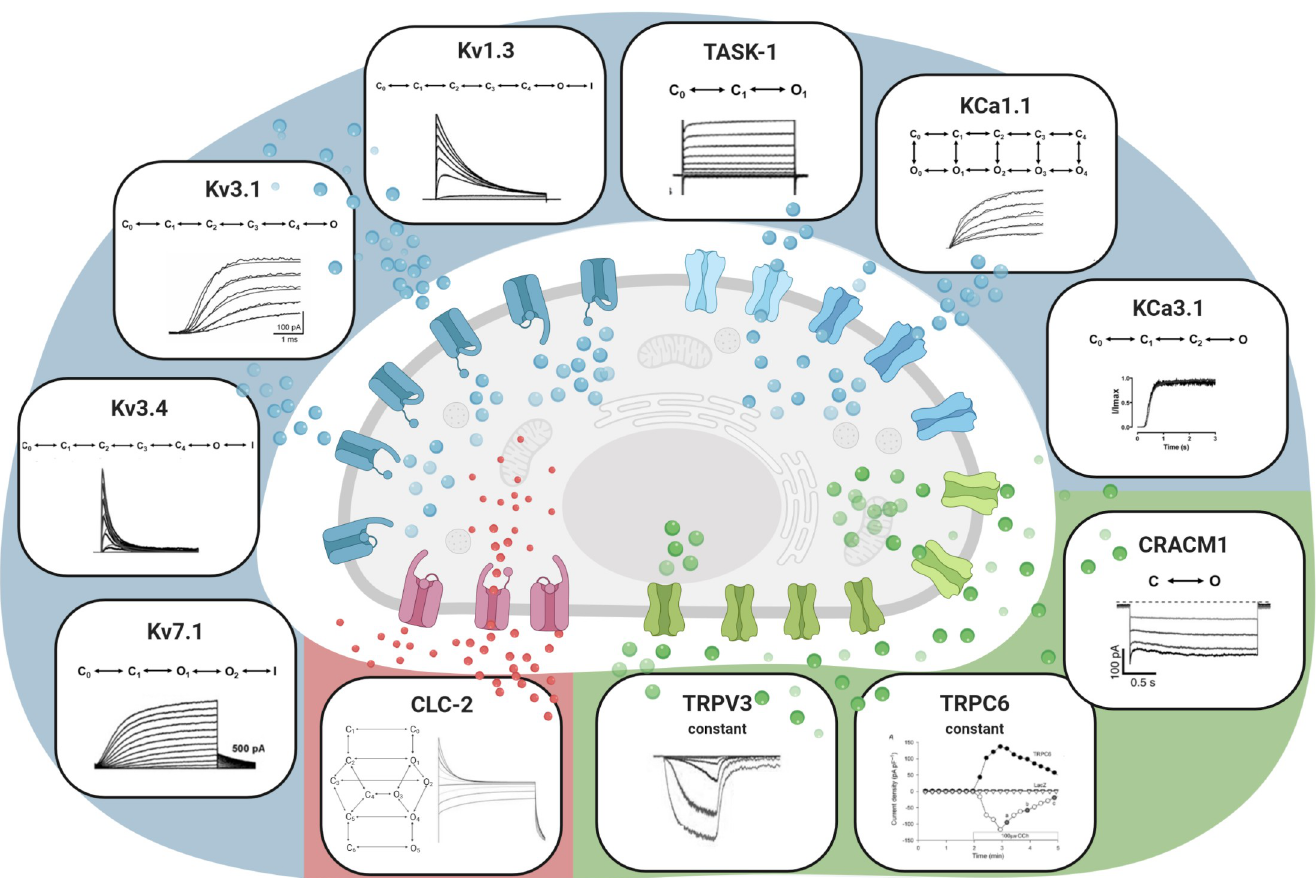
Fig 2. A549 whole-cell ion current model. The model illustrates the different ion channel types, macroscopic currents and kinetic schemes of the used hidden Markov models (HMM). Potassium channels, including Kv1.3, Kv3.1, Kv3.4, Kv7.1, TASK-1, KCA1.1 and KCa3.1 are represented in blue, green denotes the included calcium channels CRACM1, TRPV3 and TRPC6 and red represents the considered chloride channel CLC-2. See also S1 Fig. Created with BioRender.com.